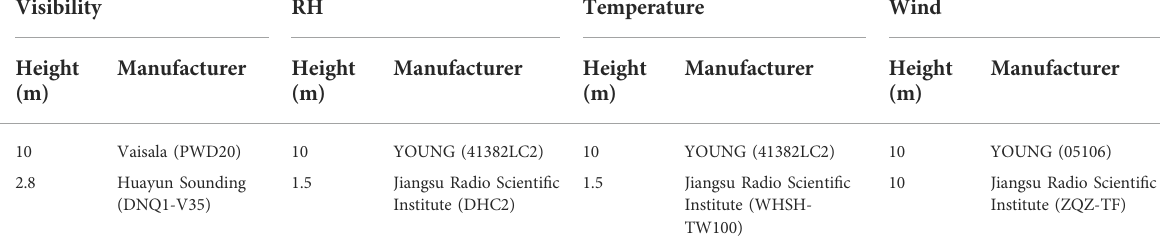
TABLE 1 Information on the observations of this study.